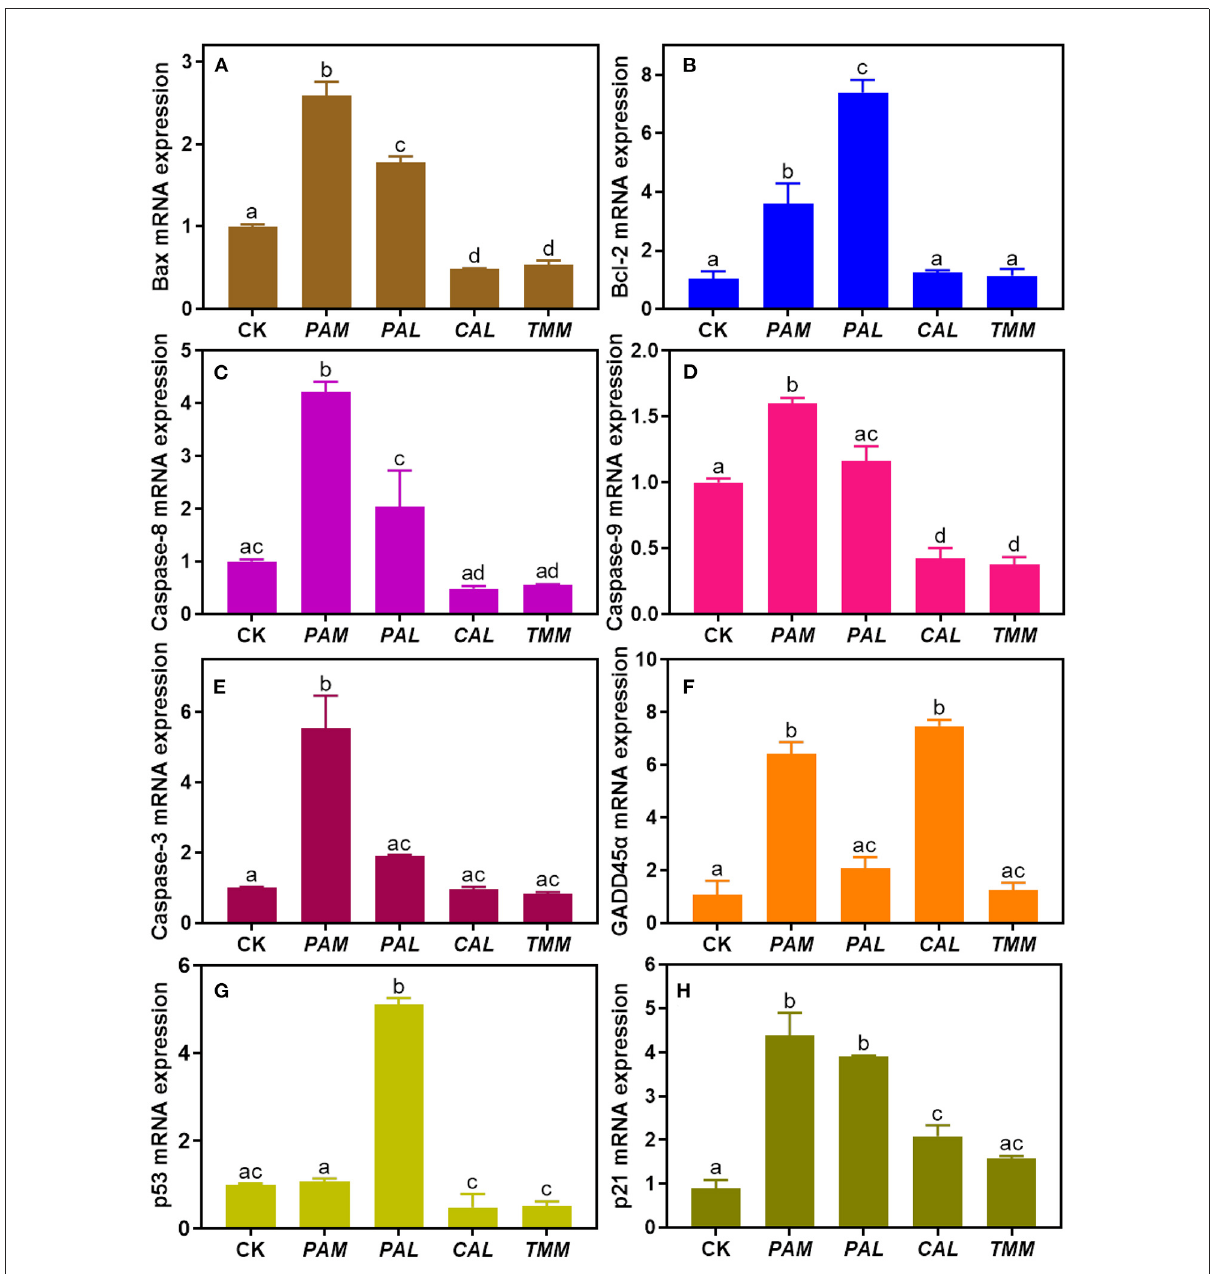
FIGURE6 The mRNA expression levels of cell apoptosis regulatory genes ( A : Bax , B : Bcl-2 , C : Caspase-8 , D : Caspase-9 , E : Caspase-3 , F : GADD45 α , G : p53 , and H : p21 ) in HGEC after being exposed to four extracts compared with the control group. The control group (CK) was treated by DMEM only. Results were represented as mean ± SD of triplicate experiments. The different letters represent significant differences at p < 0.05.